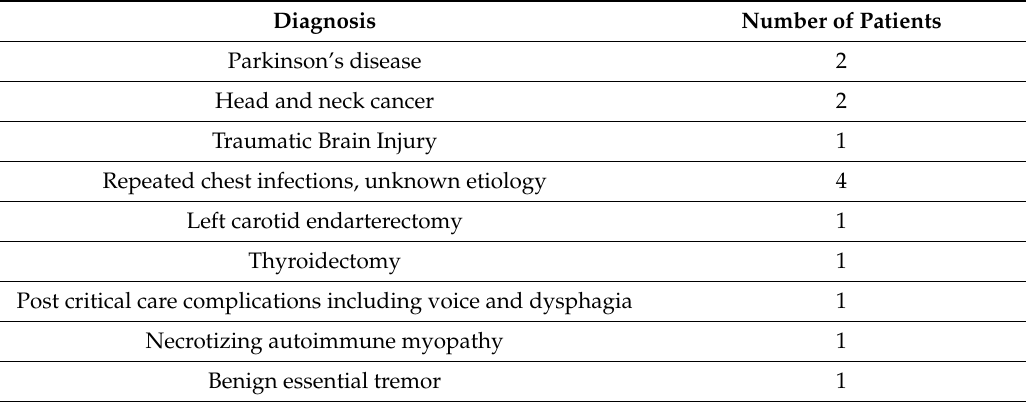
Table 5. Medical diagnoses of non-stroke